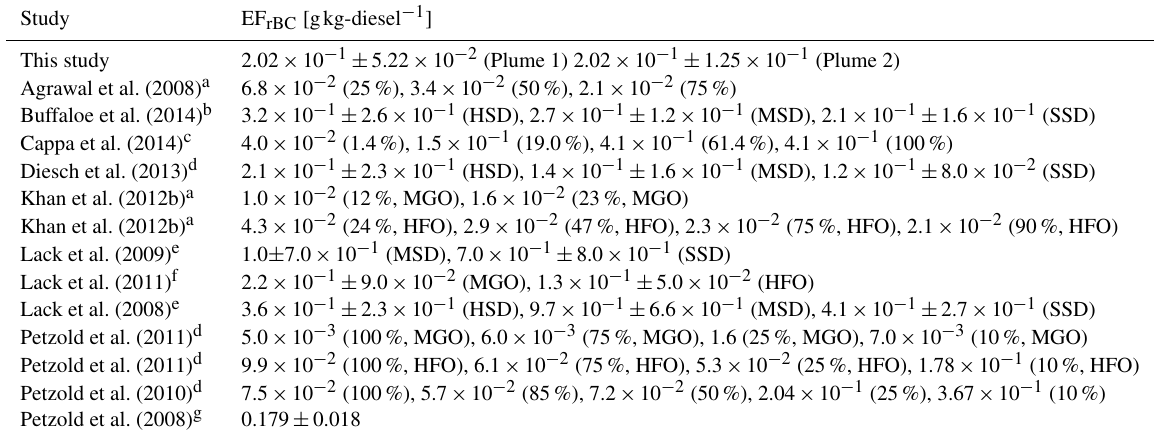
Table 5. Emission factors for black carbon; numbers in brackets indicate engine load (%), fuel type (HFO: heavy fuel oil with high sulfur content, and MGO: marine gas oil with low sulfur content), or vessel class based on gross metric tonnage (HSD: high speed diesel < 5000t, MSD: medium speed diesel 5000–30000t, or SSD: slow speed diesel > 50000t); a elemental carbon, filter measurement based on a ther- mal/optical carbon aerosol analyzer according to NIOSH 5040; b black carbon measurement based on weighted average using SP2, SP-AMS, PAS, and PSAP; c black carbon measurement based on weighted average using SP2, SP-AMS, PAS-G, PAS-B, and PSAP; d black carbon measurement based on multiple angle absorption photometer (MAAP); e light absorbing carbon measurement based on photo-acoustic techniques; f black carbon measurement based on PAS; g elemental carbon, filter measurement based on a multi-step combustion method according to VDI guideline 2465-2; the uncertainty is computed using the orthogonal distance regression (ODR) method.